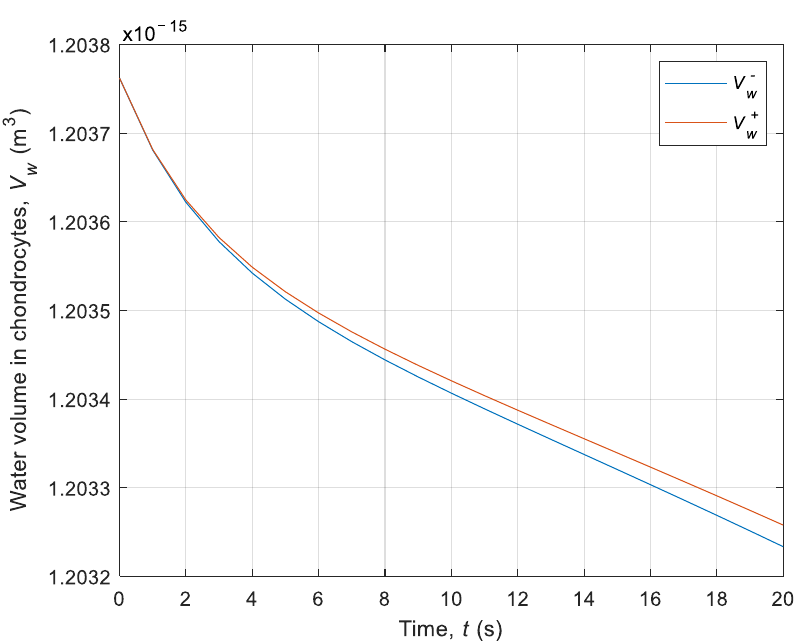
Figure 9. History of the intracellular water volume over time for transition from 22 ◦ C to − 5 ◦ C. Table 3 includes the values of intracellular quantities at the end of the given steps. The exact results of the extracellular temperature and CPA concentration can be found in previous work [41]. The obtained interval concentrations were also compared with the simulation data received by Yu et al. [13]. In individual steps, these values are close to each other. Significant discrepancies occur for steps where the temperature is low. Table 3. Values of intracellular quantities at the end of each